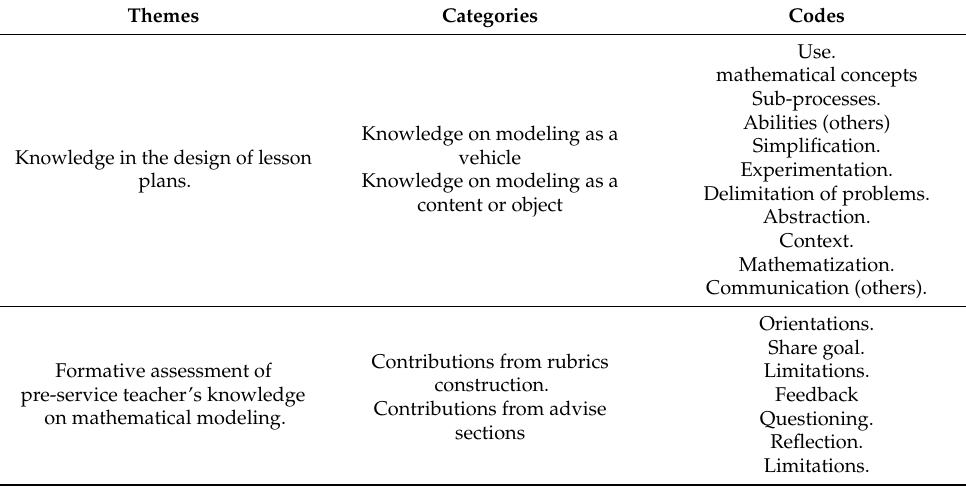
Table 2. Category and code